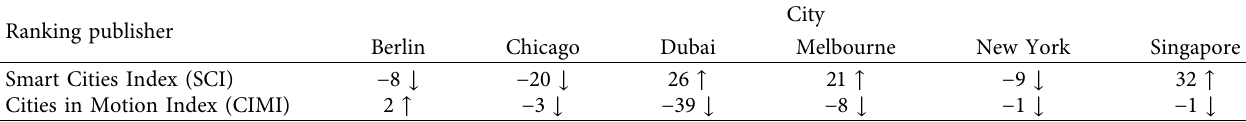
Table 6: Comparison of the change in ranking position between 2018 and 2019 for 6 common cities as given by 2 ranking